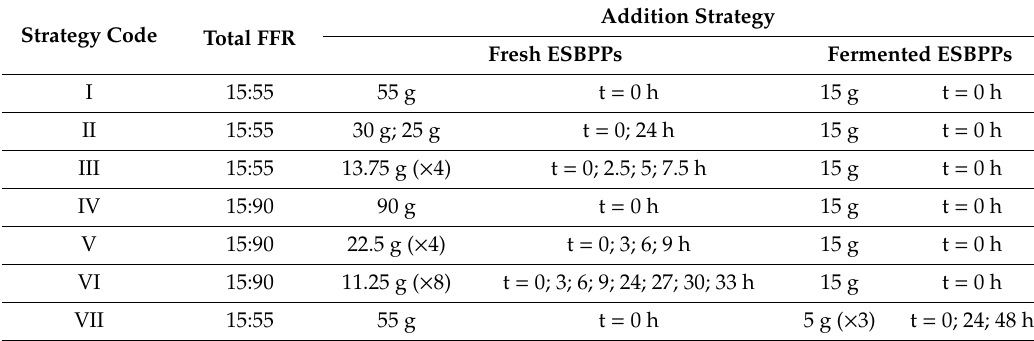
Table 1. Addition strategies used in enzymatic hydrolysis with fermented exhausted sugar beet pulp pellets